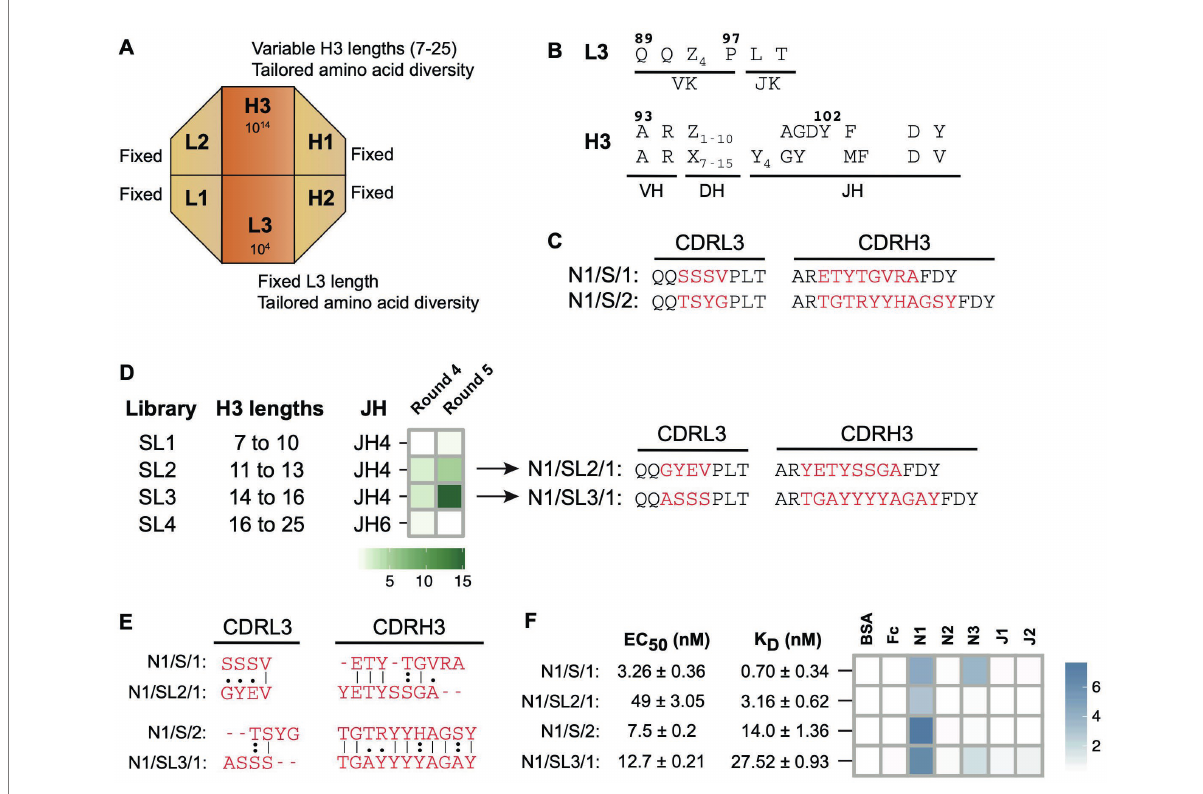
FIGURE 1 Notch-1 Fabs from Library-S. (A) Schematic representation of Library-S CDR diversity. (B) CDR diversity designs for L3 and H3. Z denotes any of the following 13 amino acids introduced at different proportions: Y (20%), S (20%), G (20%), T (6.5%), A (6.5%), P (6.5%), H (3.5%), R (3.5%), E (3.5%), F (2.5%), W (2.5%), V (2.5%), or L (2.5%). X denotes any of the following nine amino acids introduced at different proportions: Y (25%), S (20%), G (20%), A (10%), F (5%), W (5%), H (5%), P (5%), or V (5%). CDRH3 length is varied by altering the number of Z and X. (C) CDRL3 and CDRH3 sequences of two Notch-1 Fabs isolated from Library-S. Fixed anchor residues are in black and diversified CDR positions are in red. (D) Left panel: panning of Library-S sub-libraries (SL1–SL4) against Notch-1. Heatmap showing the enrichment of Notch-1 binding phages after phage display selection rounds 4 and 5. Fold enrichment is the ratio of number of phages eluted from target-coated wells to number of phages eluted from BSA-coated wells. Right panel: CDRL3 and CDRH3 sequences of Fab N1/SL2/1 (isolated from SL2) and Fab N1/SL3/1 (isolated from SL3). (E) Pairwise sequence alignments between master-and sub-library Fab CDR sequences. Only diversified CDR positions within L3 and H3 were included for the alignment. Sequences were aligned using the Needleman–Wunsch algorithm in the EMBOSS Needle server. (F) Affinity and specificity of four Notch-1 Fabs isolated from Library-S master-and sub-libraries. EC 50 and K D values were determined using multi-point Fab-ELISA and bio-layer interferometry, respectively. Fab specificity was determined using single-point Fab-ELISA at 1 μ M Fab concentration. Abs 450 values are shown as a heatmap. Notch-1, Notch-2, Notch-3, Jagged-1, and Jagged-2 are indicated as N1, N2, N3, J1, and J2,